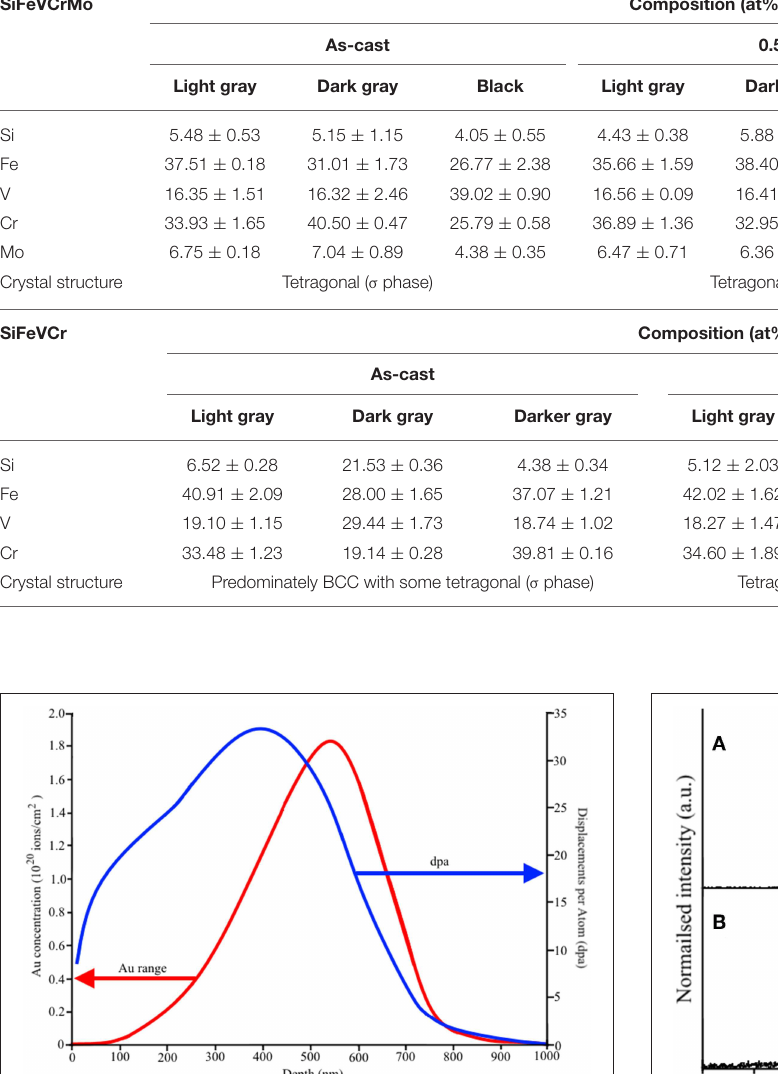
TABLE 4 | Summary of crystal structures as determined by XRD and phase compositions as determined by SEM/EDX. SiFeVCrMo Composition (at%)